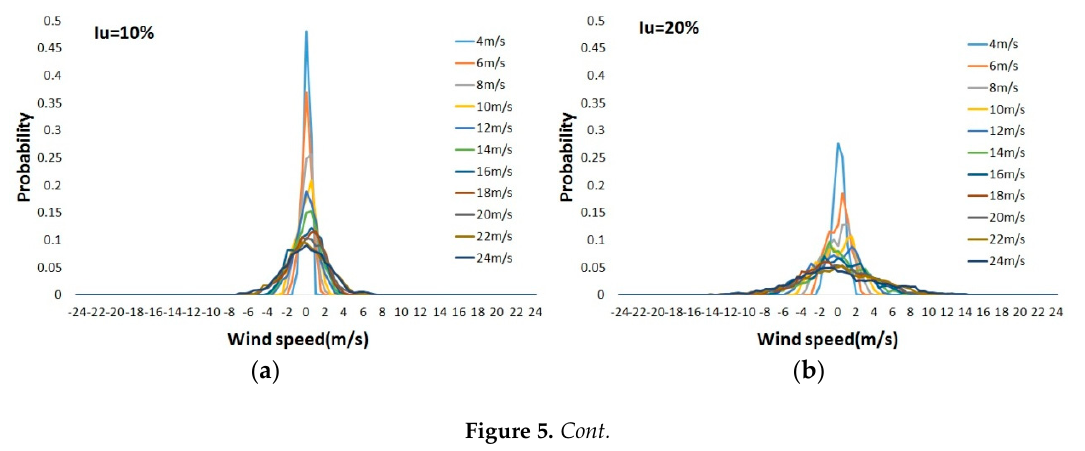
Figure 4. Turbulent wind speed.